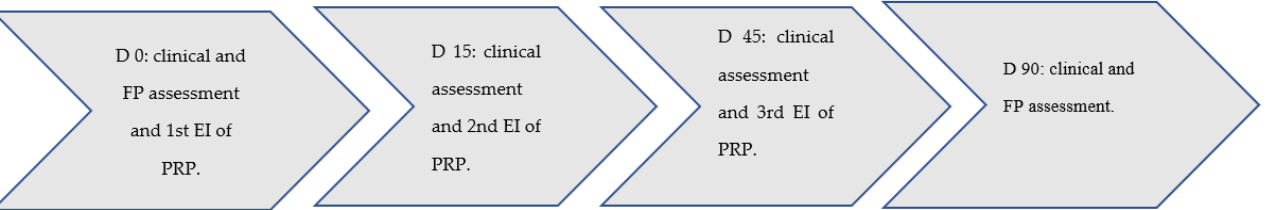
Figure 2. EI, clinical assessment and FP analysis workflow.